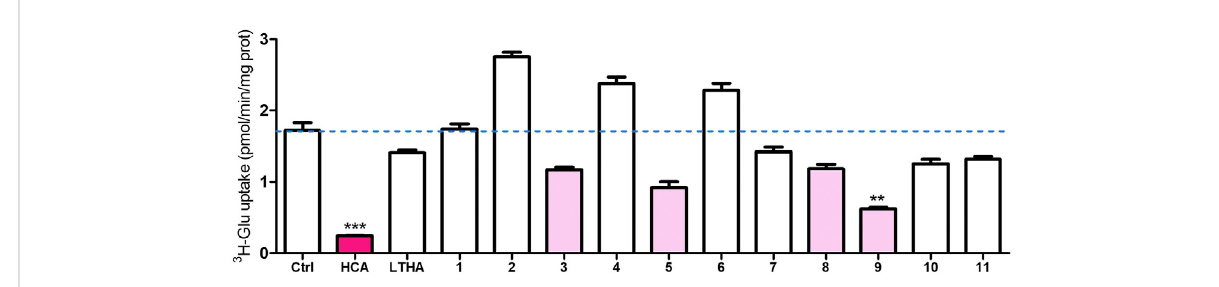
FIGURE 11 Preliminary results of 3 H-Glutamate uptake assay at an inhibitor concentration of 10 – 4 M. Ctrl: control; HCA: homocysteic acid (known system